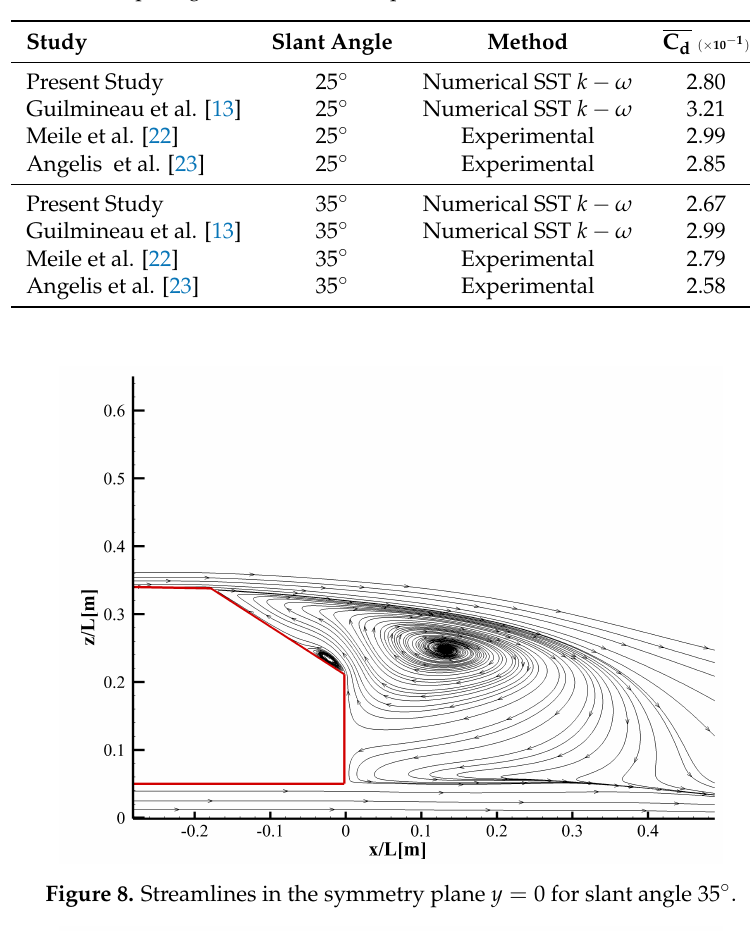
Table 2. Comparing the numerical setup with the literature at Re = 7.68 × 10 5 .